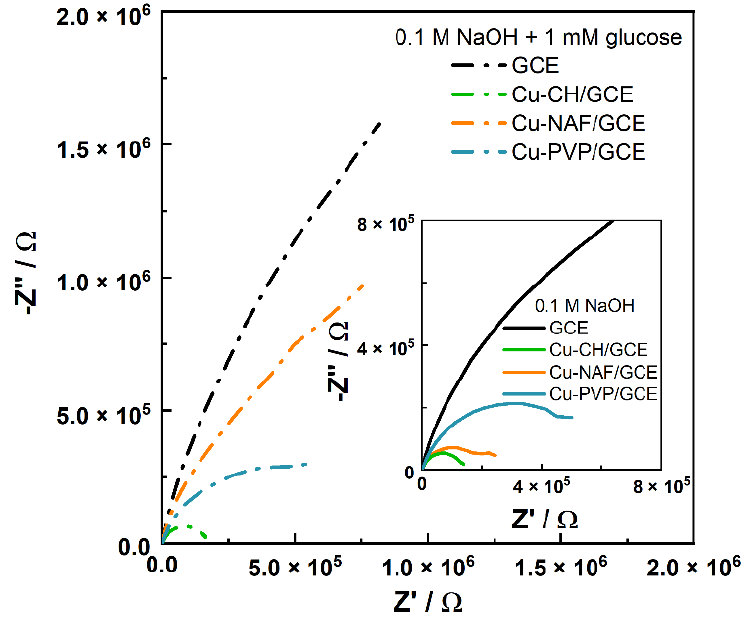
Figure 4. Impedance spectra in the Nyquist configuration for modified GCEs in the 0.1 M NaOH and 0.1 M NaOH + 1 mM glucose